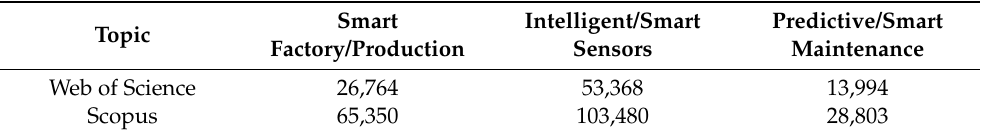
Table 3. Results of topics searched for burst detection analysis (1 December 2020).